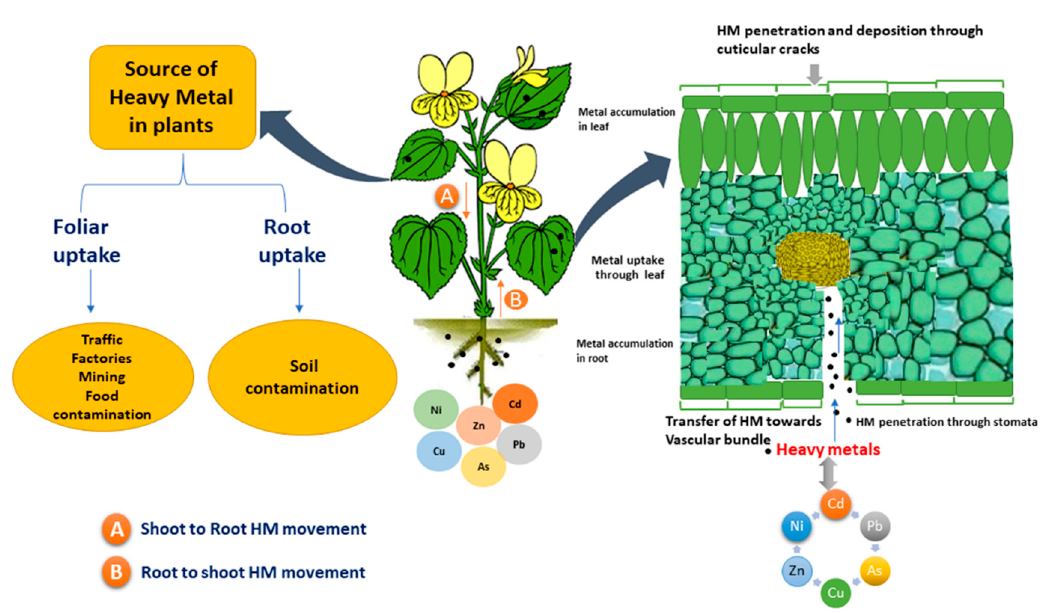
Figure 1. Sources of heavy metals, and foliar, root uptake of heavy metals in plants.